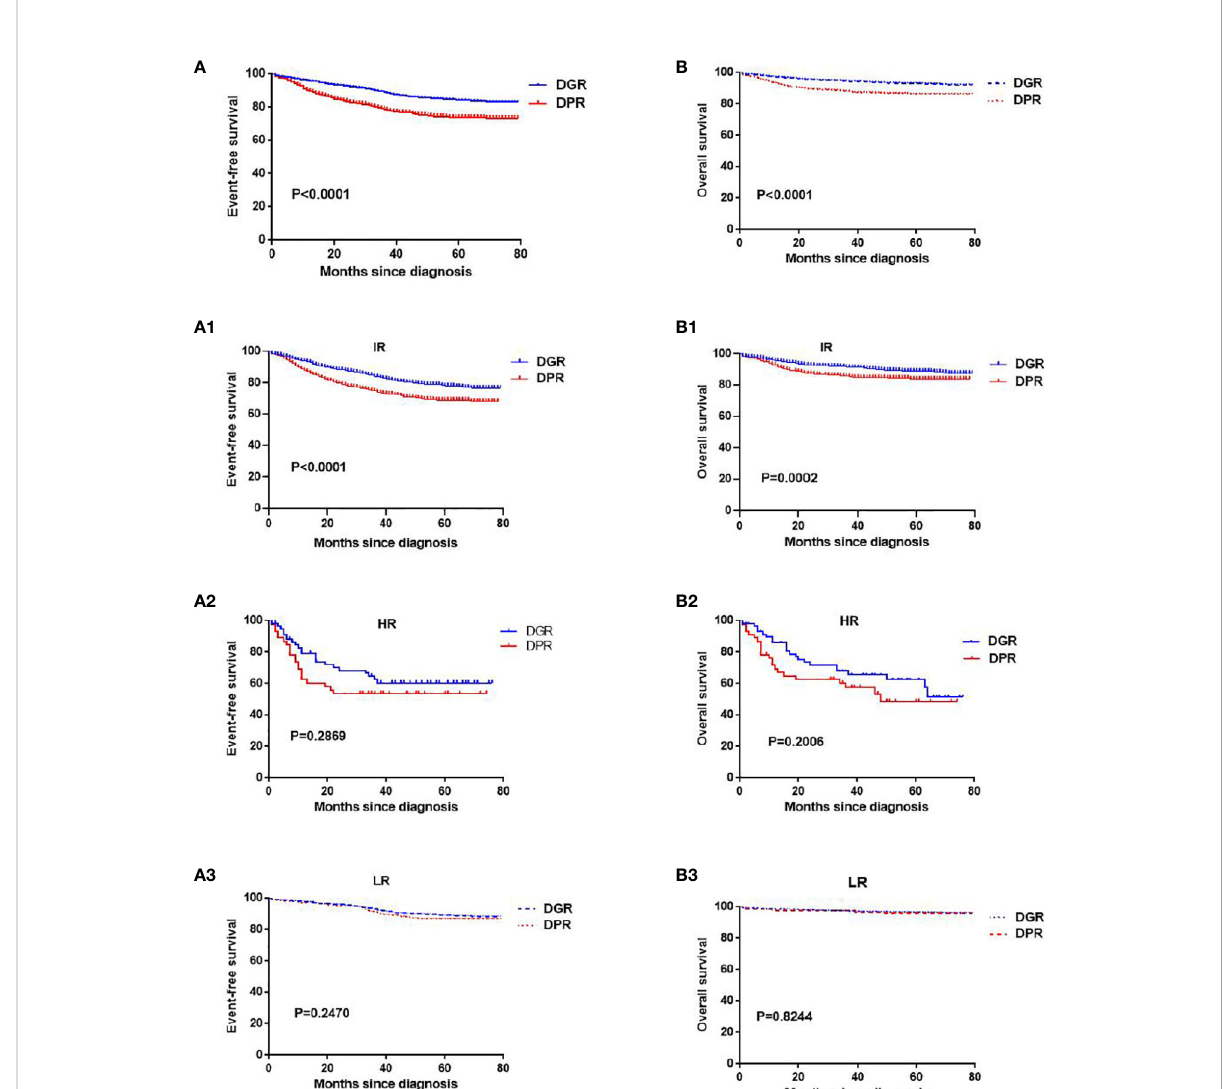
FIGURE 2 Kaplan – Meier analyses of the event-free survival and overall survival in the DGR and DPR groups. Panels ( A, A1 – A3 ) indicate the event-free survival of all patients, patients at intermediate risk, patients at high risk, and patients at low risk, respectively. Panels ( B, B1 – B3 ) indicate the overall survival of all patients, patients at intermediate risk, patients at high risk, and patients at low risk,